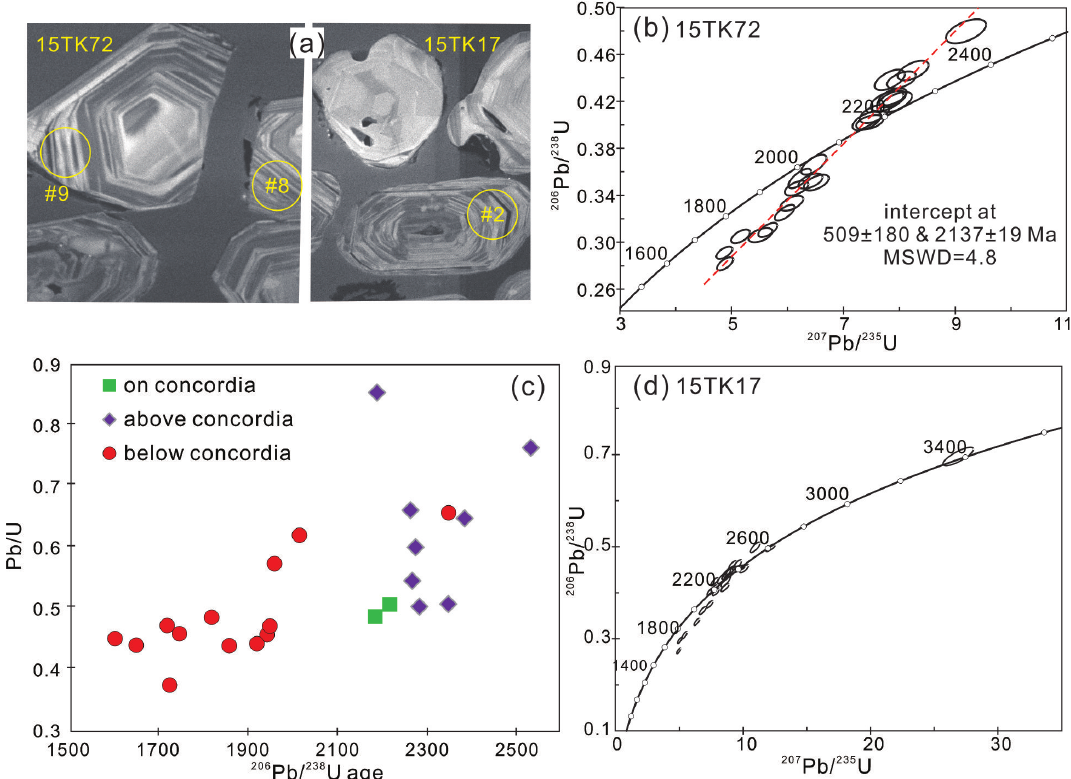
Figure 5. ( a ) Cathodoluminescence images for zircon of metatuff of the Tongkuangyu Cu deposit, North China Craton; ( b , d ) U-Pb concordia diagrams for 15TK72 and 15TK17; and ( c ) A plot of 206 Pb/ 238 U versus Pb/U for